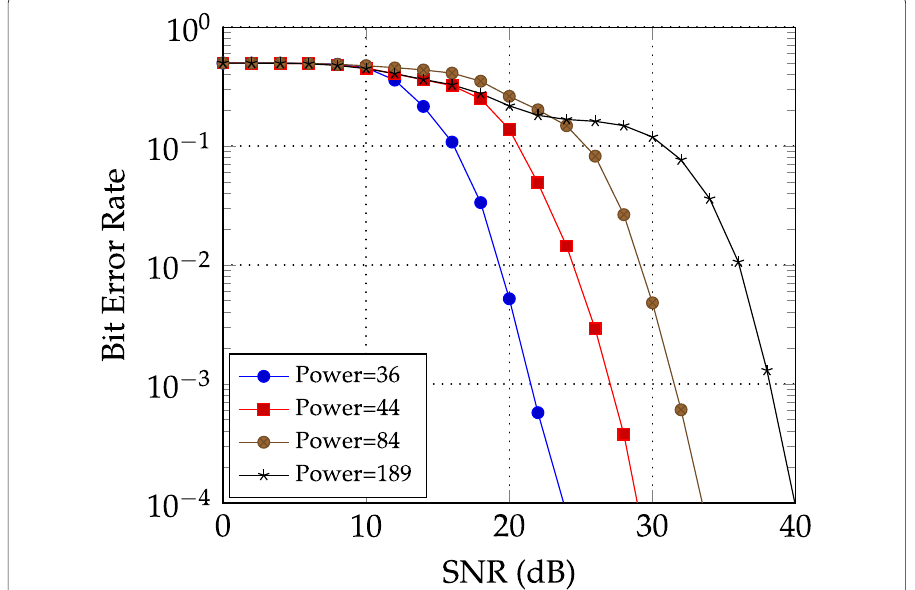
Fig. 1 Effect of the post-filter norm on the system’s performance: BER vs